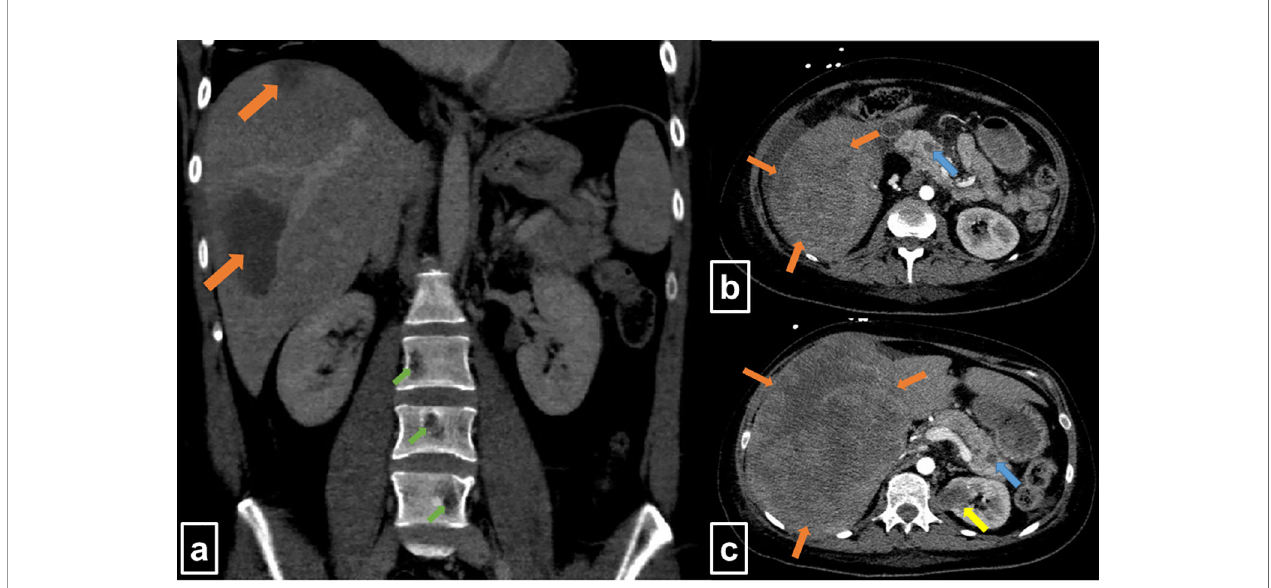
FIGURE 1 | Contrast-enhanced computed tomography at initial staging (Mar 2020). (A) The coronal slice shows two large hypodense lesions in the right liver lobe (orange arrows) and osteolytic lesions of lumbar vertebrae (green arrows). (B, C) Transversal slices display extended, hypointense lesions in the liver (orange arrows), as well as lesions in the pancreas (blue arrows) and the left kidney (yellow